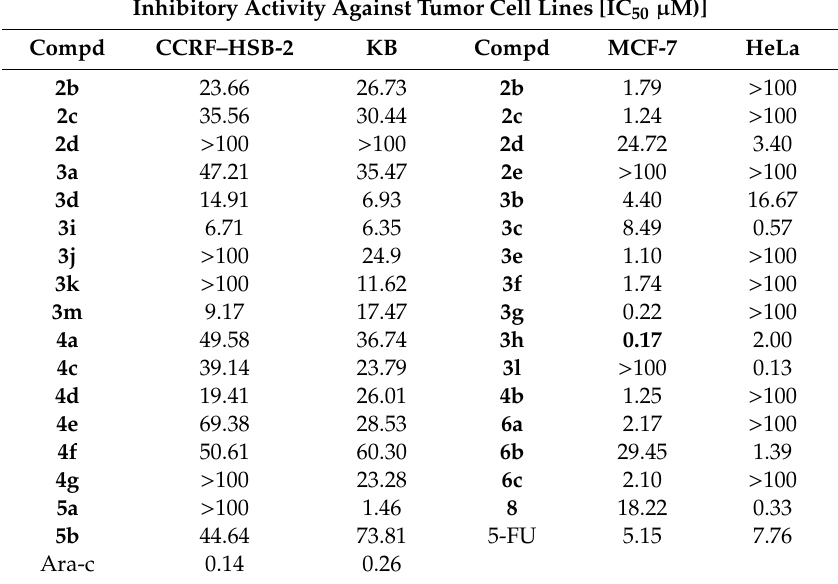
Table 2. The inhibitory activities of the synthesized 5-deazaalloxazine derivatives against CCRF-HSB-2, KB, MCF-7 and HeLa tumor cell